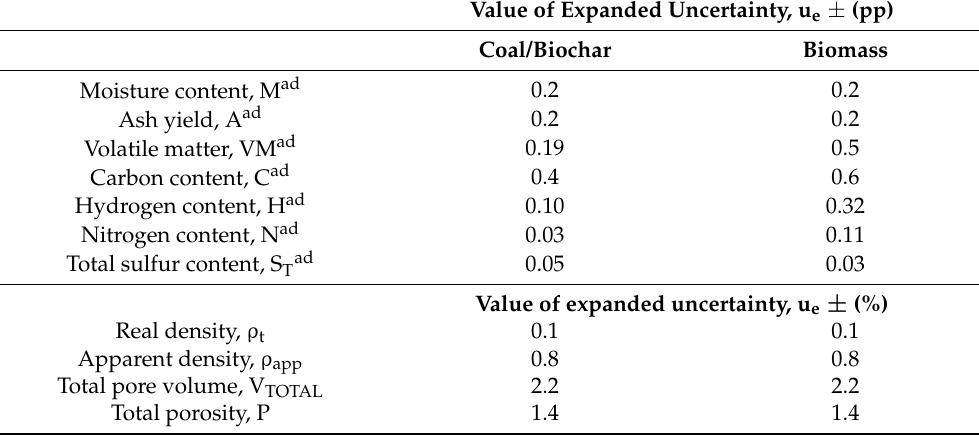
Figure A10. TG/DTG curves obtained for hazelnut shells biochar. Table A1. The values of expanded uncertainty ( α = 0.05) of performed determinations ( ad –air dried basis).